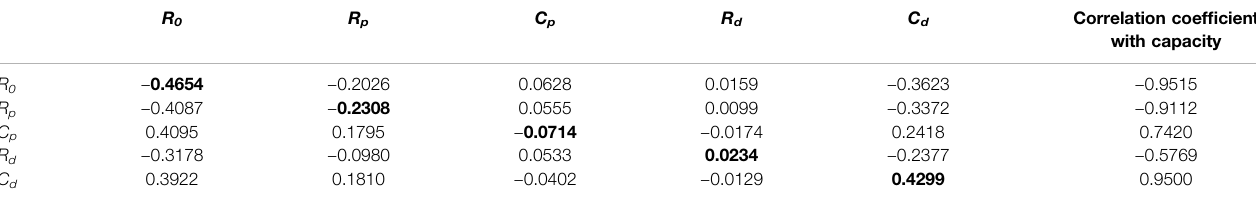
TABLE 5 | Direct path coef fi cient and indirect path coef fi cient of Cell 1 (60%